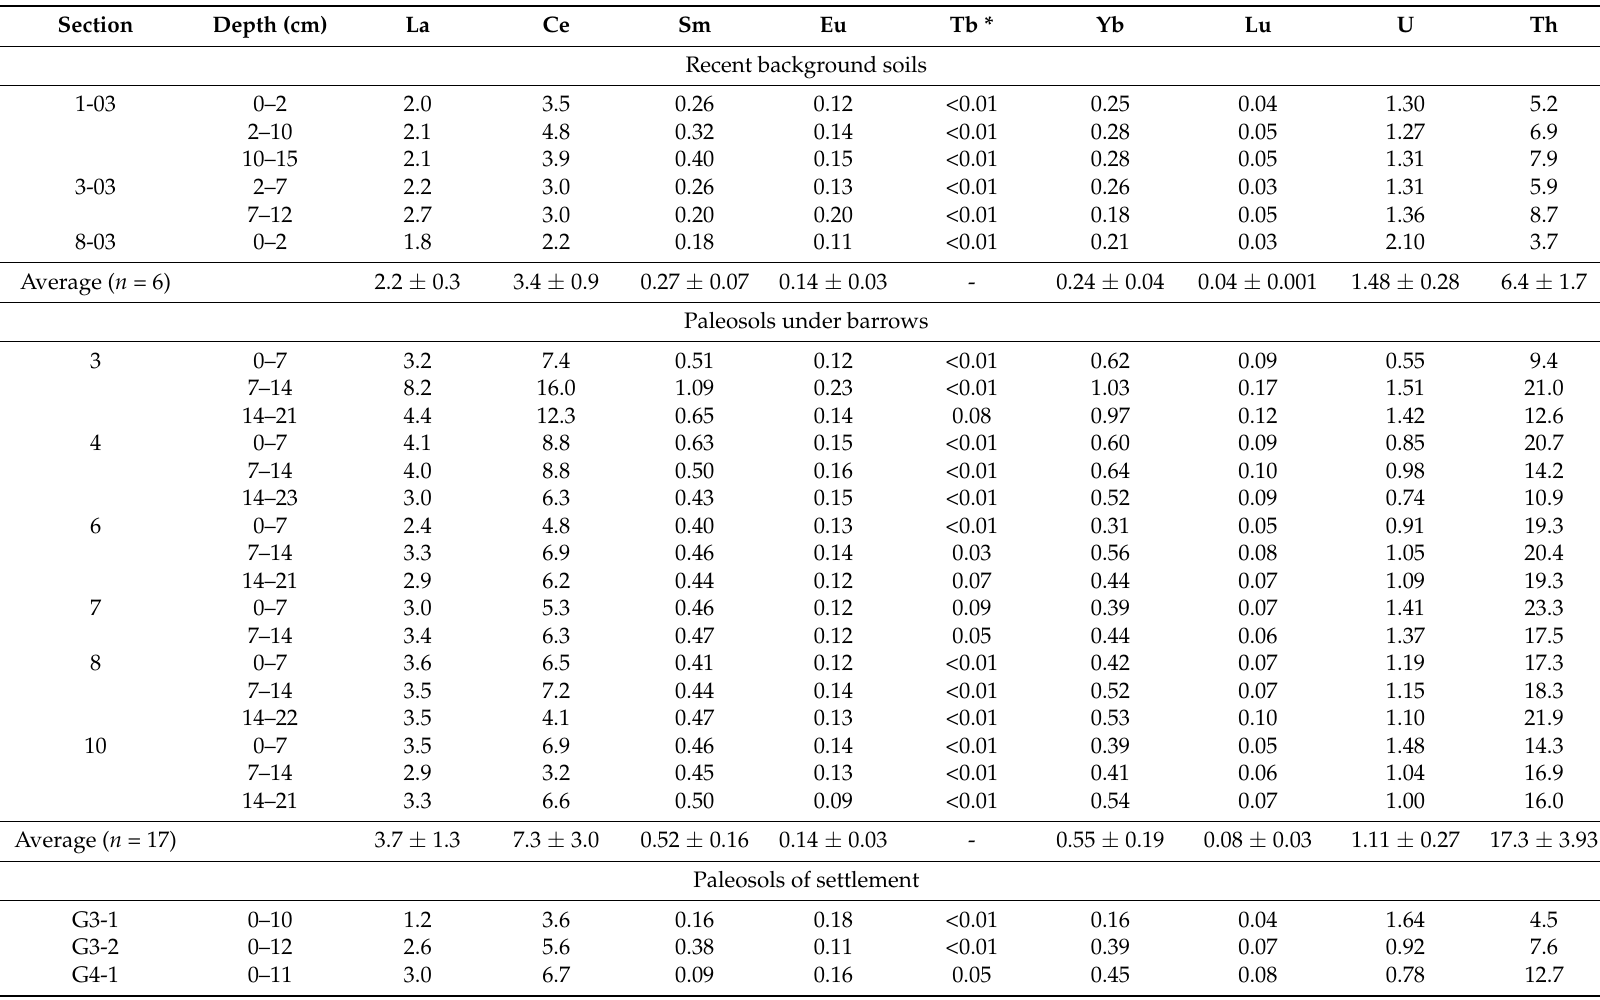
Table 3. The content of some lanthanides and actinides in the humic acids from humus horizons of paleosols and recent soils of the forest-steppe zone of the Southern Urals, mg · kg − 1